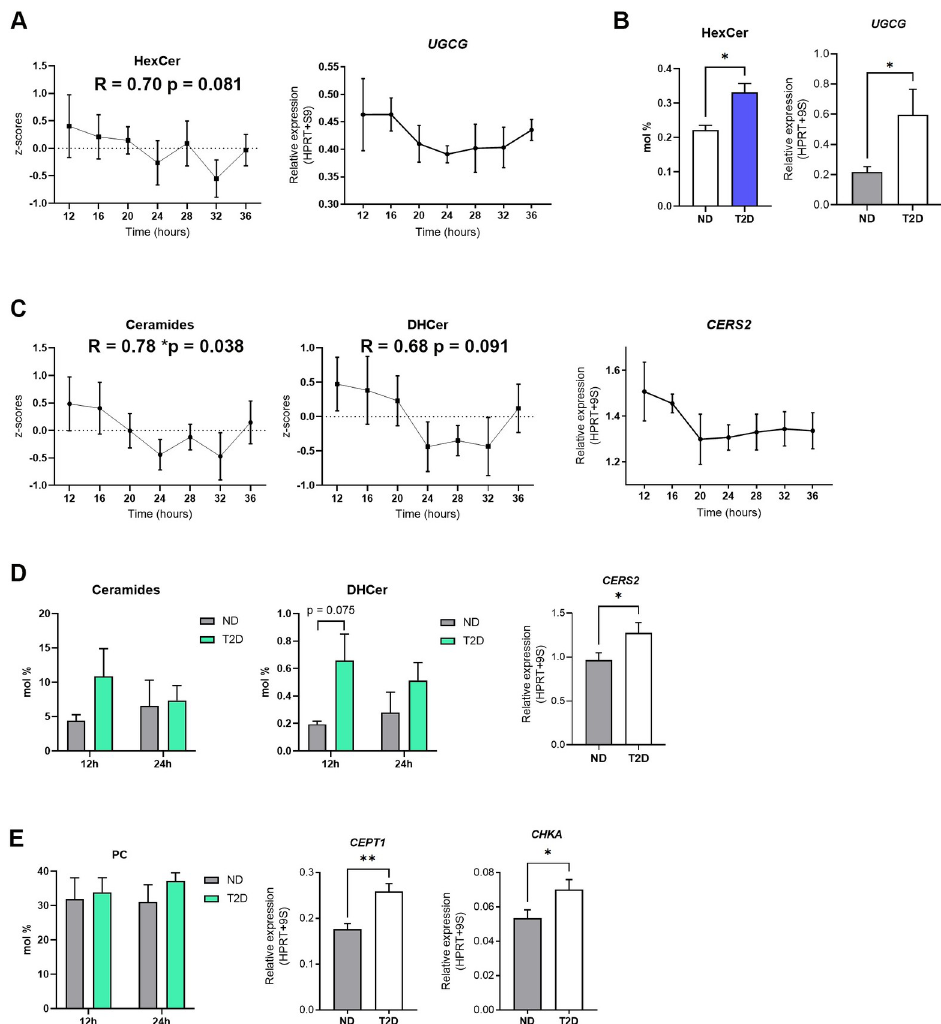
Fig 4. Diurnal ceramide levels correlate with transcript profiles encoding for key enzymes involved in their biosynthesis. (A) Average temporal profiles of HexCer species (left, n = 6) and RT-qPCR temporal gene expression profile of UGCG ( right, n = 3). See also S1 and S4 Data. (B) Comparison of the relative HexCer level changes (mol%) in ND versus T2D islets collected at 24 h after in vitro synchronization (left, n = 6) with the UGCG expression measured in ND and T2D islets (right, n = 9). See also S3 and S4 Data. (C) Average temporal profiles of ceramide species (left, n = 6), DHCer (middle, n = 6), and RT-qPCR temporal gene expression profile of CERS2 (right, n = 3). See also S1 and S4 Data. (D) Comparison of the relative ceramide (left) and DHCer (middle) level changes (mol%) in ND versus T2D islets collected 12 h and 24 h after synchronization ( n = 6) with the CERS2 expression measured in ND and T2D islets (right, n = 9). See also S3 and S4 Data. (E) Comparison of the relative levels of PC (mol%) in ND versus T2D islets collected 12 h and 24 h after synchronization (left, n = 6) with the CEPT1 (middle) and CHKA (right) expression measured in ND and T2D islets ( n = 9). See also S3 and S4 Data. The R numerical value indicates the corresponding Pearson correlation coefficient and its associated p -value. Transcript levels were normalized to HPRT and 9S expression. Data are represented as mean ± SEM, unpaired 2-tailed t test; p � < 0.05, p �� < 0.01. DHCer, dihydroceramide; HexCer; hexosylceramide; HPRT, hypoxanthine-guanine phosphoribosyltransferase; ND, nondiabetic; PC, phosphatidylcholine; T2D, type 2